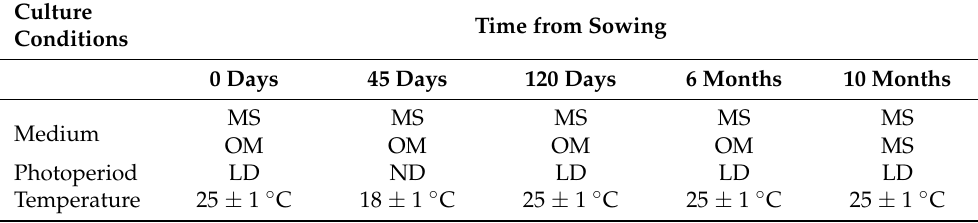
Table 1. Timing and culture conditions adopted for seed germination of Anacamptis longicornu and Ophrys panormitana .